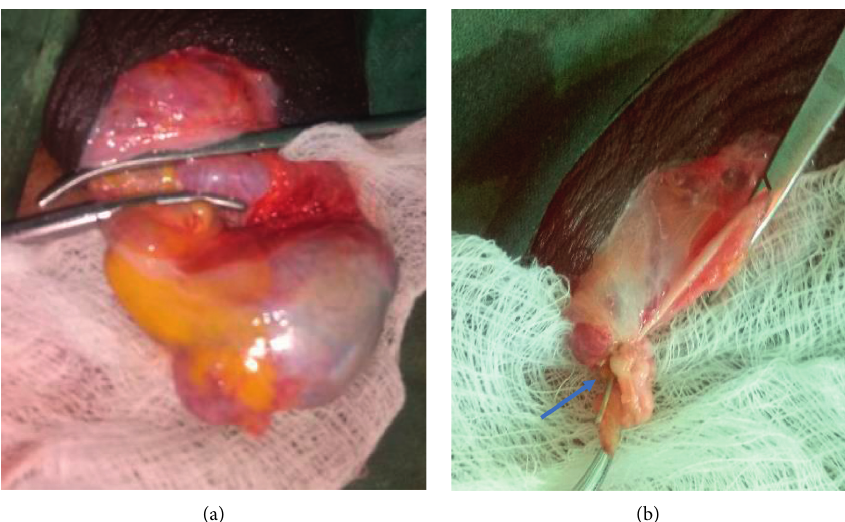
Figure 1: Simple orchidectomy. (a) Testicular vessels clamped. (b) Proximal testicular vascular stump ligated (arrow) and vas deferens clamped.